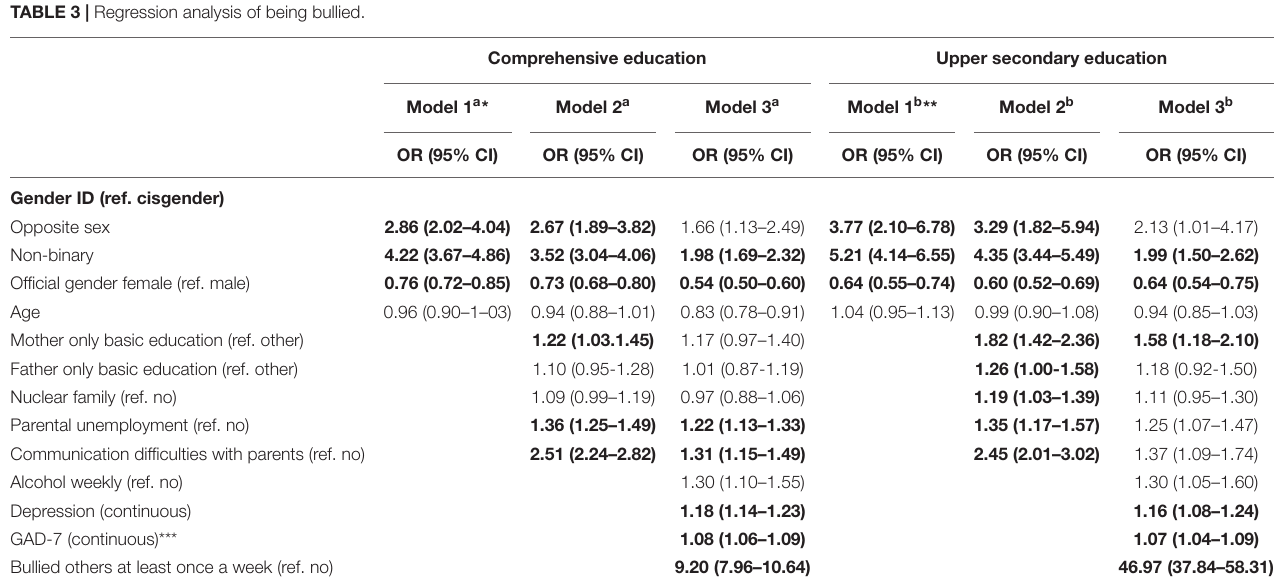
( Table 3 ; Model 1 a ∗ ). In the upper secondary education sample, a similar pattern emerged but with even stronger associations ( Table 3 ; Model 1 b ∗∗ ).